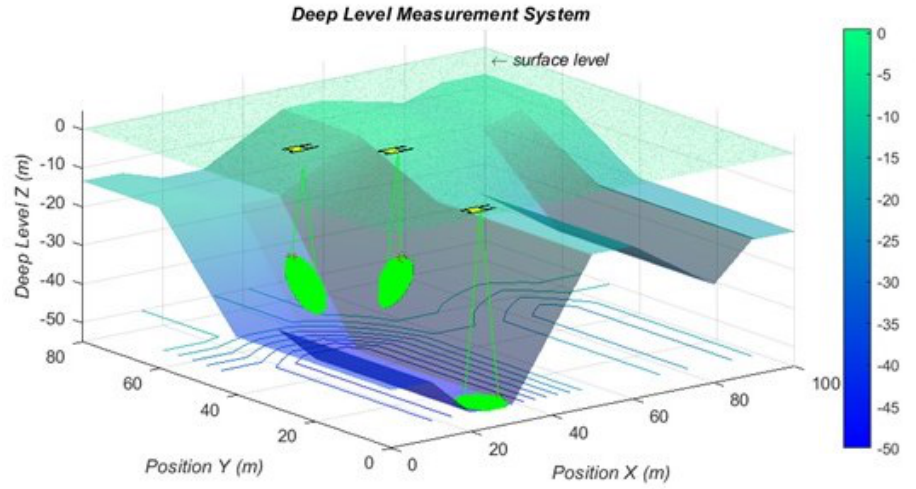
Figure 5. Generated underwater topography based on